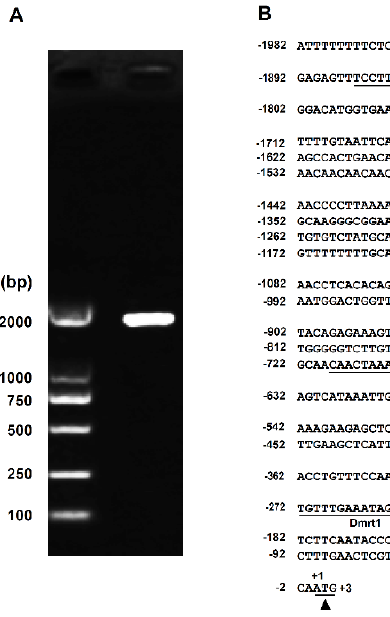
Figure 1. Cloning and sequencing of the Nile tilapia Sox30 promoter. ( A ) Cloning of the proximal promoter region containing a 1982 bp sequence upstream of the translational initiation site (ATG) of the Nile tilapia Sox30 gene. The first nucleotide of the transcription initiation site (ATG) is defined as + 1 and its upstream region is indicated as minus number. ( B ) Bioinformatics prediction of potential cis-regulatory elements (CREs) for transcription factors within proximal promoter of the Nile tilapia Sox30 gene. The predicted TATA box and CREs for the binding of various transcription factors are underlined. The putative translation start site is indicated by the solid triangle. The potential core binding site for doublesex and mab-3 related transcription factor 1 (Dmrt1) located in the region from − 274 to − 254 within the Nile tilapia Sox30 promoter.